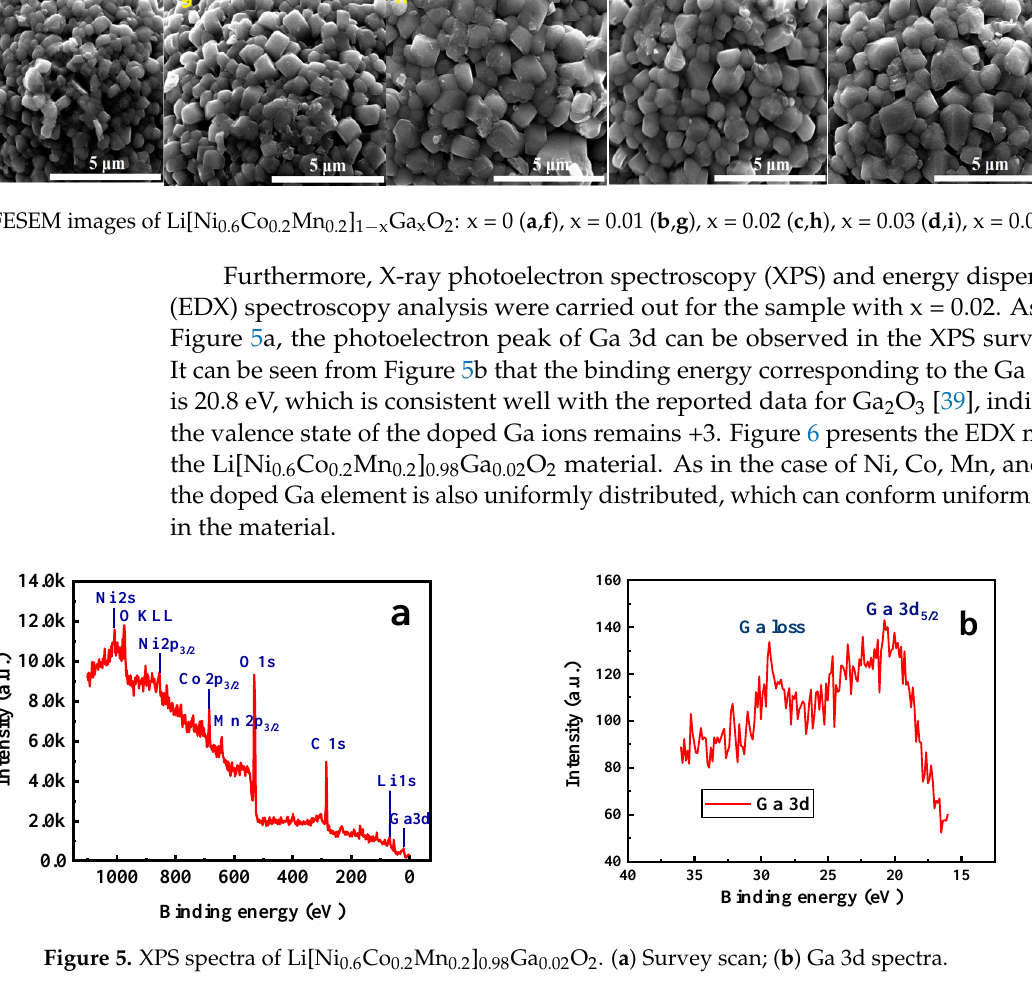
Figure 4. FESEM images of Li[Ni 0.6 Co 0.2 Mn 0.2 ] 1-x Ga x O 2 : x = 0 ( a , f ), x = 0.01 ( b , g ), x = 0.02 ( c , h ), x = 0.03 ( d , i ), x = 0.05 ( e , j ).